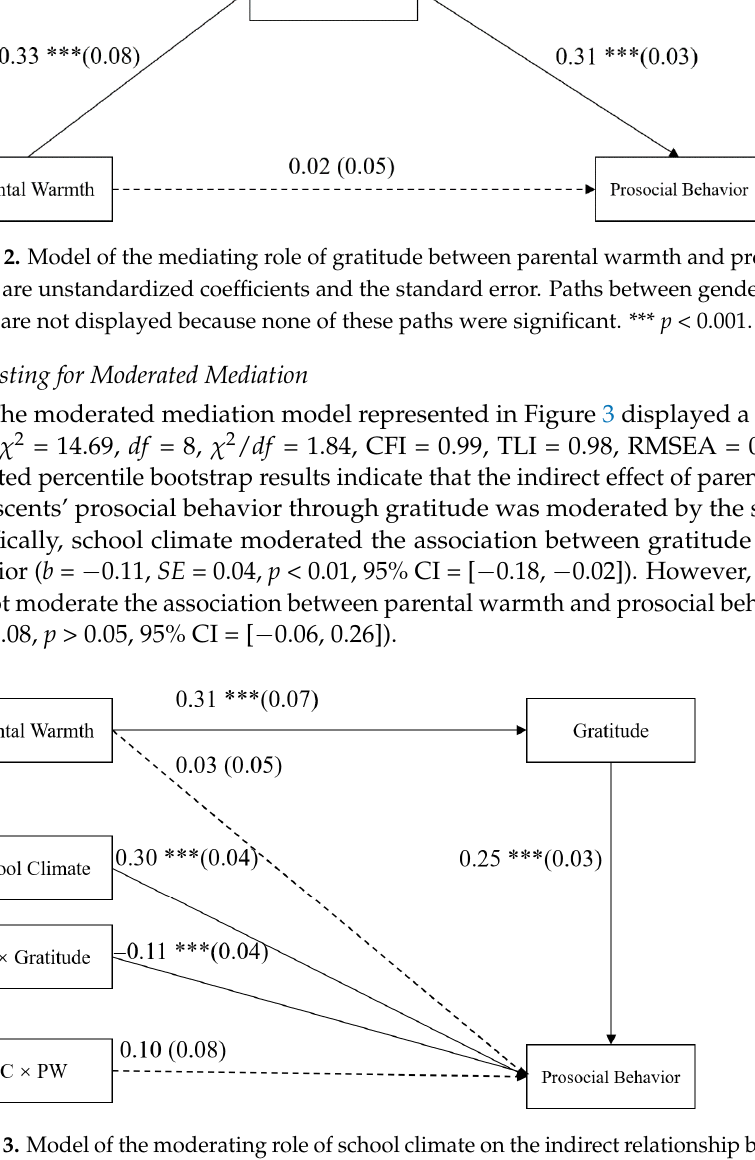
Table 1. Descriptive statistics and correlations for all variables.